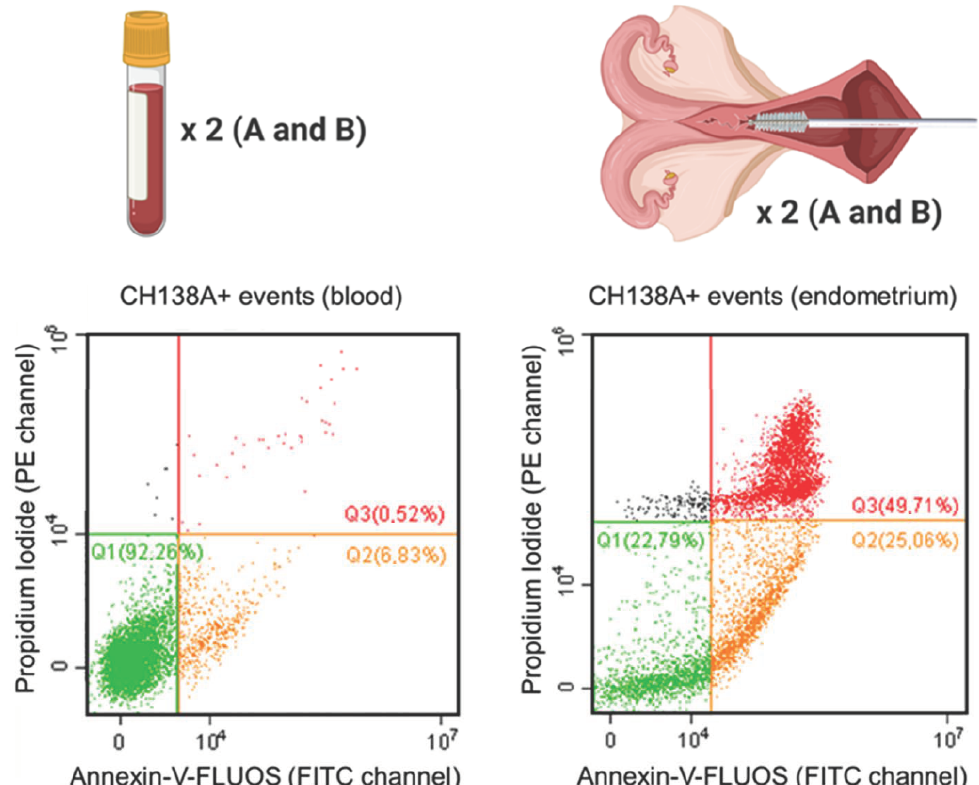
Figure 1. Viability of isolated blood and endometrial polymorphonuclear leukocytes (PMN) repre- sented by Annexin-V-FLUOS (FITC channel) versus the propidium iodide (PI; PE channel) scatter plot. This figure shows the viable (Q1 = Annexin − /PI − ), apoptotic (Q2 = Annexin + /PI − ) and necrotic (Q3 = Annexin + /PI + ) CH138A + PMN in a representative blood and endometrial (70% PMN on endometrial cytology) sample from a Holstein-Friesian cow 21 days in milk. In total, 15 blood and endometrial samples were collected from Holstein-Friesian cows at 9–37 days in milk. Samples were processed in duplicate (A and B), with prior CH138A immunolabeling (CH138A = bovine granulocyte marker). The repeatability of the viability assessment was calculated between samples A and B in endometrium and